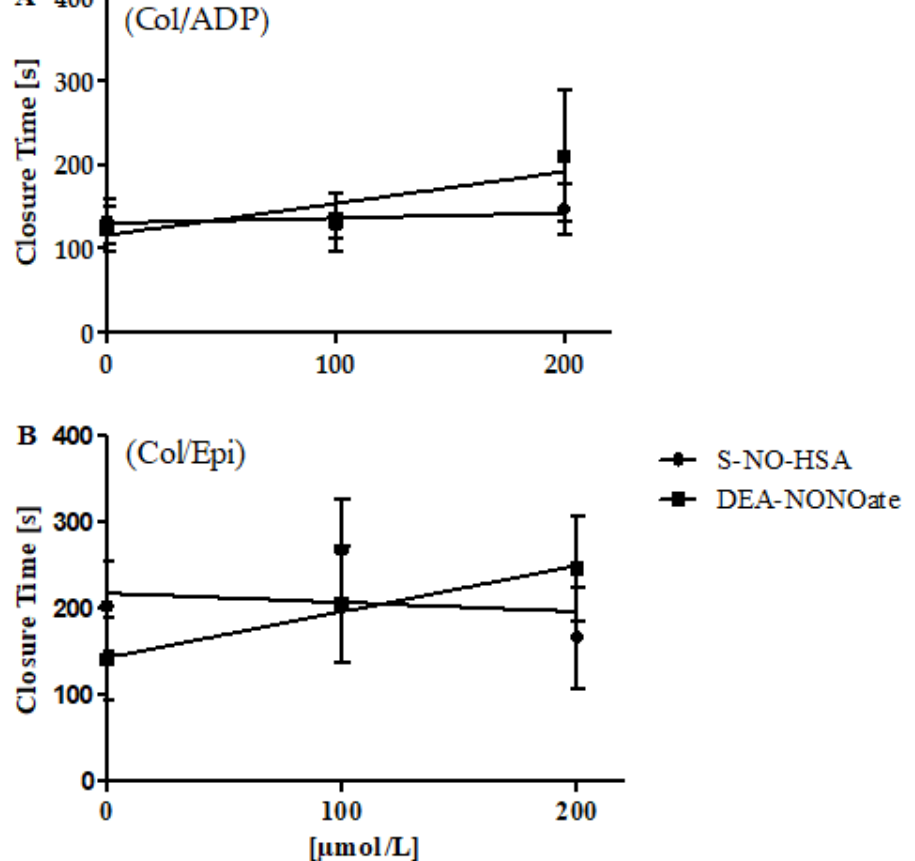
Figure 3. Effects of increasing concentrations of S-NO-HSA or DEA-NONOate on PFA 200 values in WB. Panel ( A ): Utilizing cartridges coated with collagen/ADP, addition of S-NO-HSA ( n = 12) had no effect on CloTs, while the addition of equimolar concentrations of DEA-NONOate ( n = 8) led to dose-dependently prolonged CloTs. Linear regression analysis showed that slopes differ significantly ( p = 0.02639). Panel ( B ): Utilizing cartridges coated with collagen/epinephrine, addition of S-NO-HSA ( n = 12) had no effect on CloTs, while the addition of equimolar amounts of DEA-NONOate ( n = 10) led to prolonged CloTs. Linear regression analysis showed that the slopes differ significantly ( p = 0.006435). The results are presented as mean ± SD. The data at 0 µ mol/L represent the values of the appropriate controls (no NO-donor added).